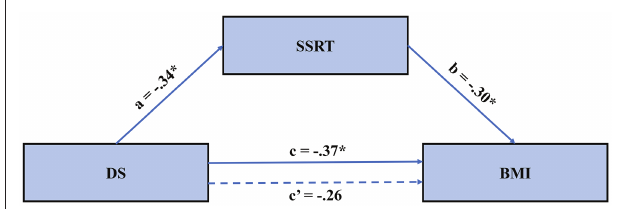
FIGURE 3 | The mediated model of the effect of disgust sensitivity on BMI. Results suggested that the effect of disgust sensitivity on BMI is fully mediated through food-specific inhibitory control. BMI, body mass index; DS, disgust sensitivity; SSRT, stop-signal reaction time.